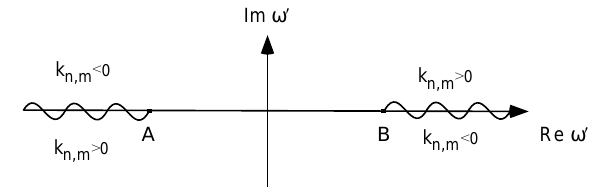
FIG. 8. Complex plane v 0 with cuts indicated by the wavy line. The first cut goes along the real axis from 2‘ to A, and the second one from B to ‘ . Function (cid:107) (cid:110) (cid:44) (cid:109) (cid:115) v 0 (cid:100) takes positive and negative values on the edges of the cuts, as shown in the figure. depend on s , and both positive and negative values of s on the right-hand side give the same result.